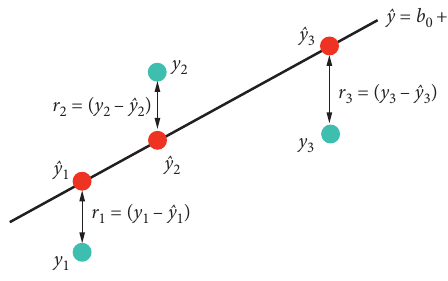
Figure 3: Regression